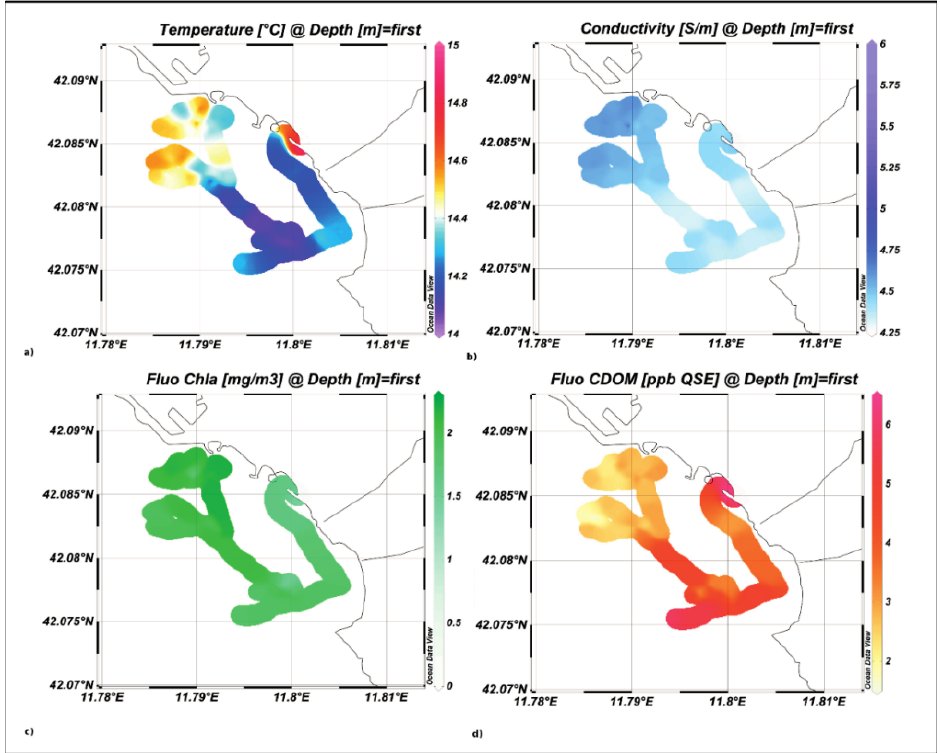
Figure 16. In situ Spectra acquisitions: ( a ) temperature; ( b ) conductivity; ( c ) Chla and ( d ) CDOM fluorescence isosurface